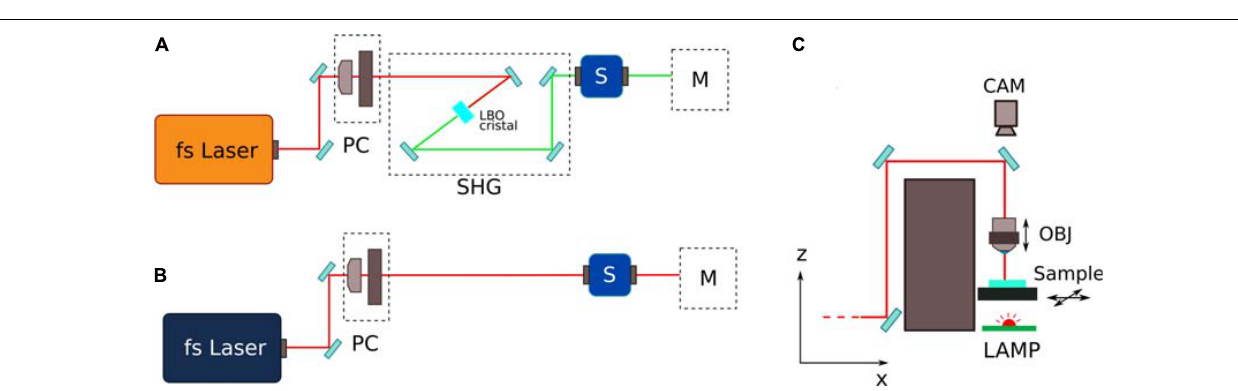
FIGURE 2 | Schematic of the femtosecond laser fabrication line. (A,B) represent the line for the fabrication of the fused silica reservoirs and for the 2PP laser writing respectively. PC represents the power control unit, composed by a halfwave plate and by a linear polarizer. SHG represents the second harmonic generation stage, composed by a Lithium triborate (LBO) crystal with incident angle based phase matching. M represents the sample movement stage; (C) shows a ZX scheme of the movement stage, with a movable focusing objective (OBJ) and sample holder. A bottom led lamp and a top camera (CAM) are included for alignment and real time monitoring of the fabrication